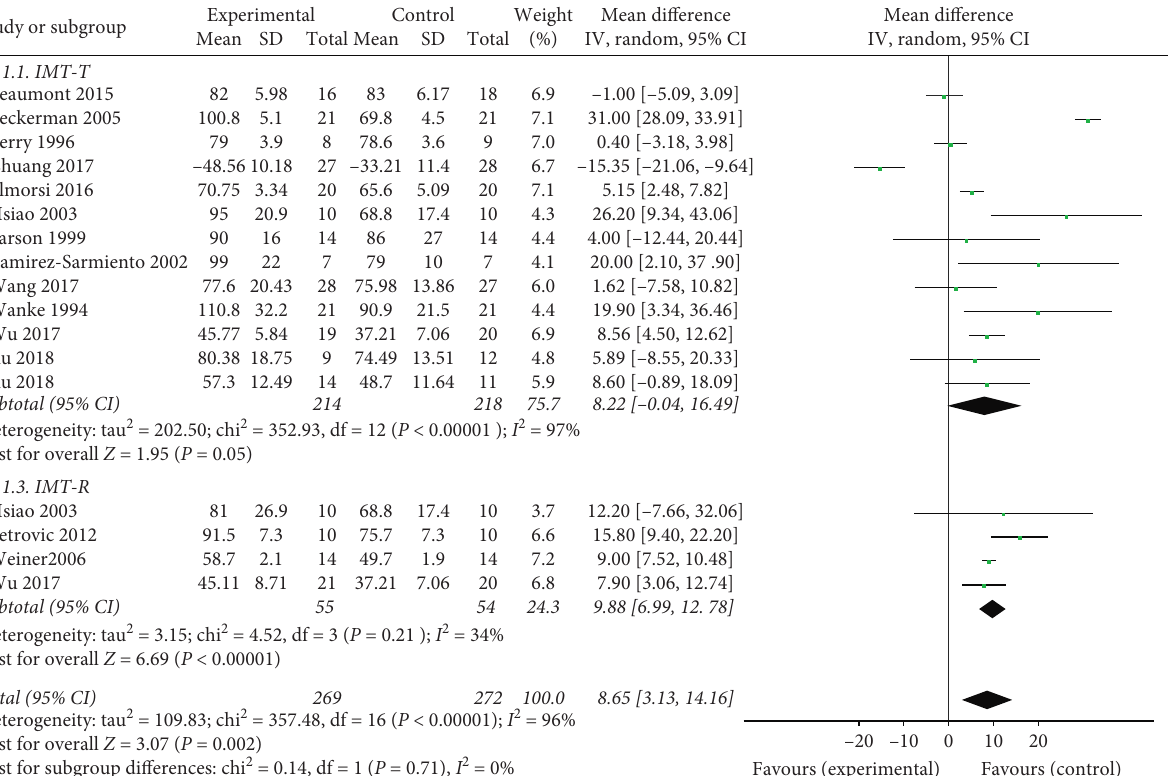
Figure 4: Effects of breathing exercises on P